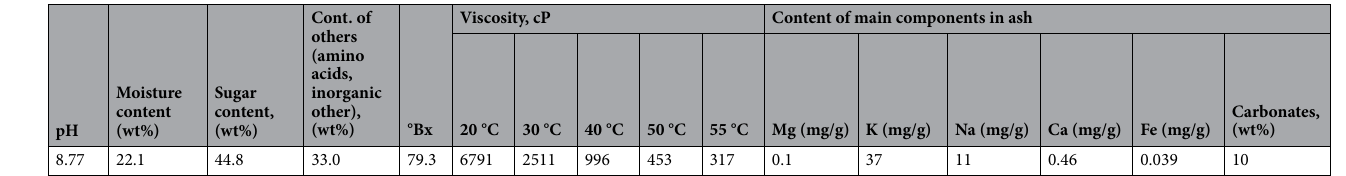
Table 4. Properties of the sugar beet molasses used for preparation of activated carbon. °Bx (Degrees Brix)—a measure of the amount of dissolved sugar in water. 1°Bx means 1 g of sucrose in 100 g of aqueous solution.